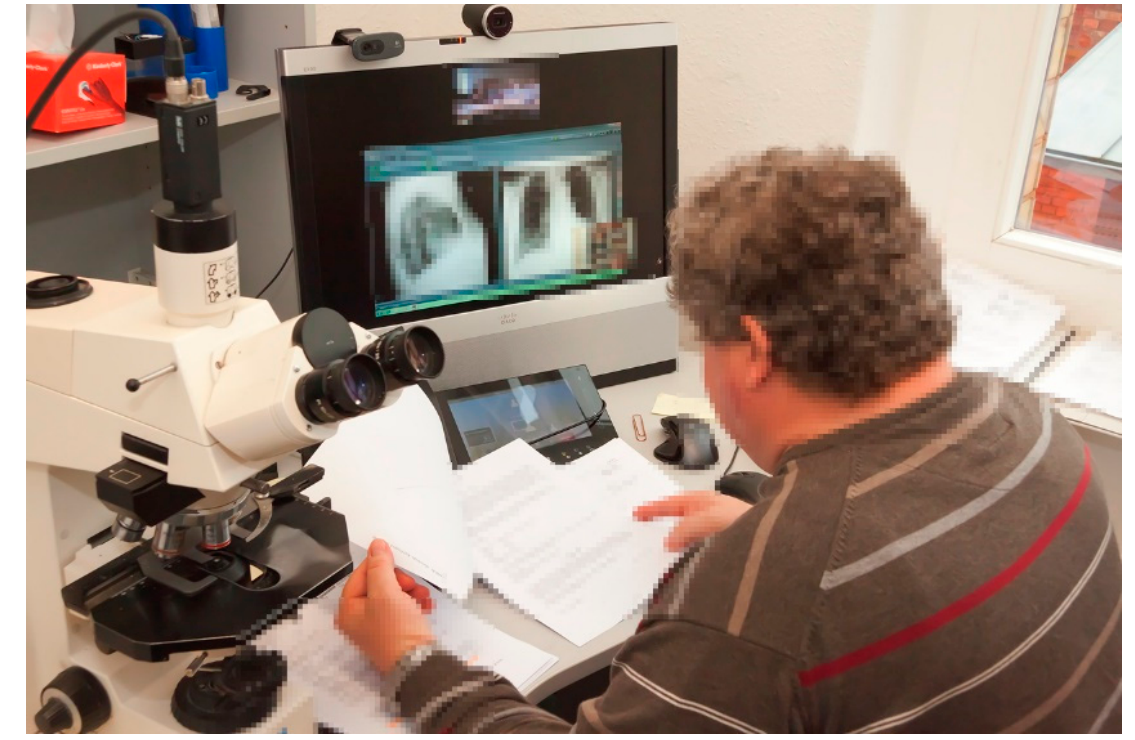
Figure 9. Telepathology. The telepathology workstation of this pathologist shows the pathologist’s desk during a tumour conference. He can work on his microscope while following the conference on his monitor. During the few minutes that the pathologist is needed in a typical teleconference, he may be seen and heard and show slides (see Figure 5). The higher productivity that is achieved in this way is particularly important given the few pathologists commonly